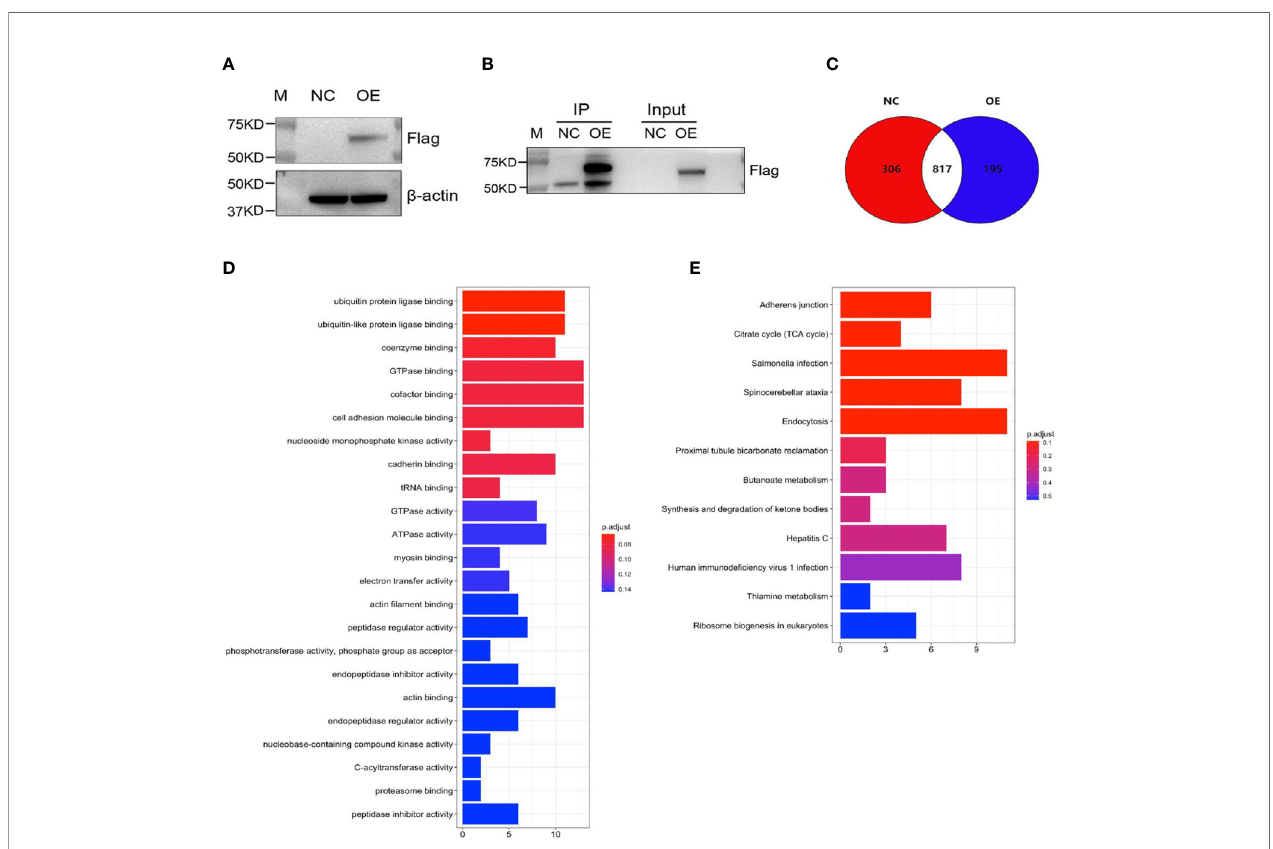
FIGURE 5 | Screening of B4GALNT2 gene interaction proteins by mass spectroscopy-assisted Co-IP. MDA-MB-231 cells were transfected with lentivirus and the target gene was overexpressed. (A) Successful overexpression of 3×Flag-fused B4GALNT2 gene. (B) Detection of proteins of the whole cell lysate of overexpressed cells (Input-OE) and the normal cell (Input-NC) controls, con fi rmation of the normal exposure of Flag tag and its recognition by Anti-Flag antibody, and veri fi cation of the ability of IP in protein enrichment. (C) A Venn diagram illustrates the number of identical and different proteins in the experimental group and the control group. (D, E) The results of GO and KEGG pathway enrichment analyses for 195 interacting protein genes identi fi ed speci fi cally in the OE group. Note: NC=normal control; OE=overexpression of the B4GALNT2